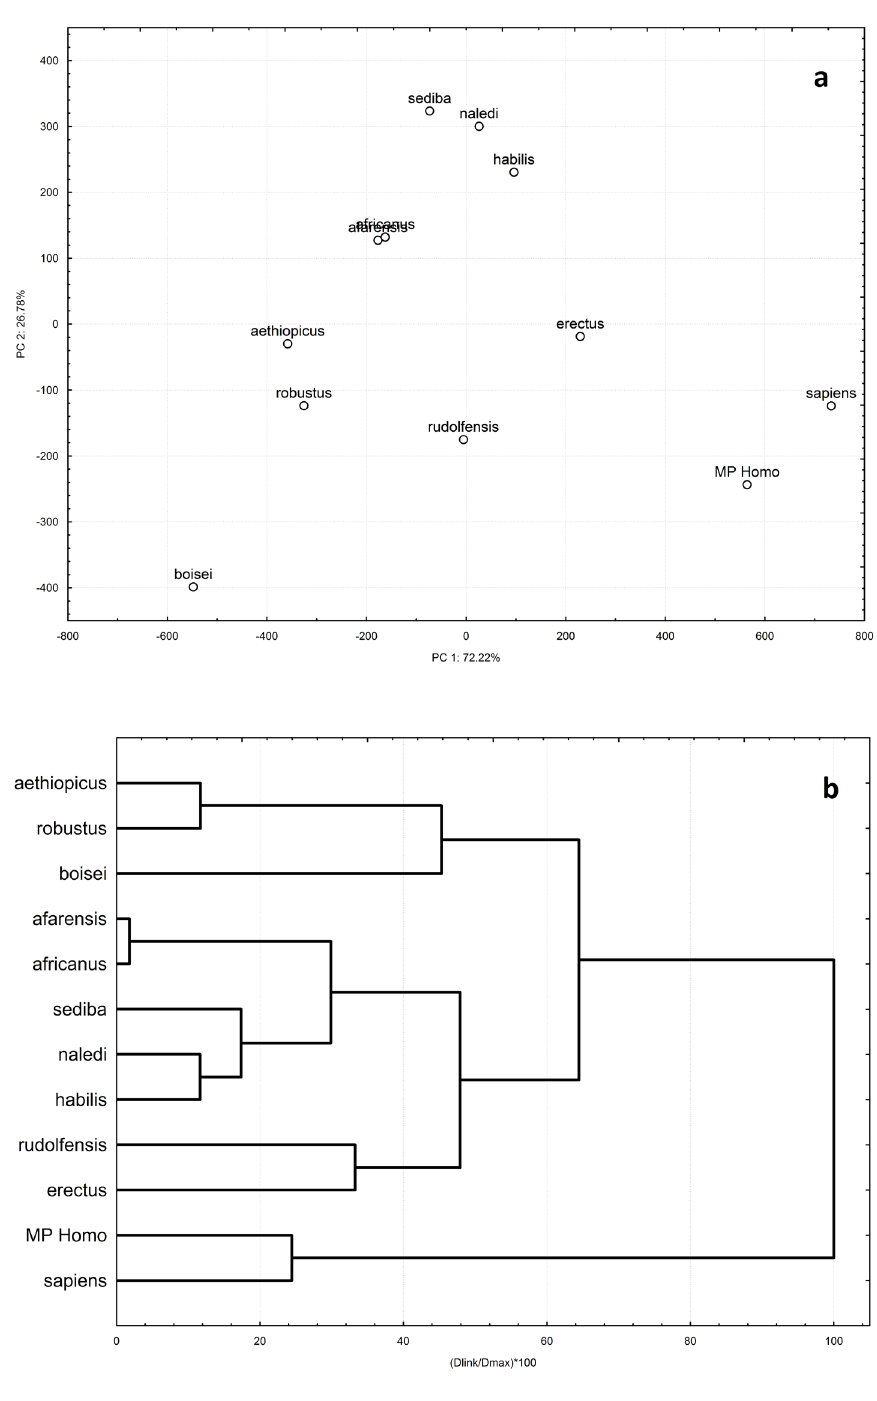
Figure 1 - More inclusive analysis, performed over 24 craniometric variables and 12 hominin taxa. 1 a (above) Bidimensional graph formed by the first two Principal Components, showing the morphological affinities among H. naledi with its contemporary fossil hominins. 1 b (below) Dendrogram obtained by means of the Cluster Analysis, following Single Linkage criteria over Euclidian Distance matrix obtained from the first three Principal Components, showing the close relationship among Homo naledi , Homo habilis and Australopithecus sediba